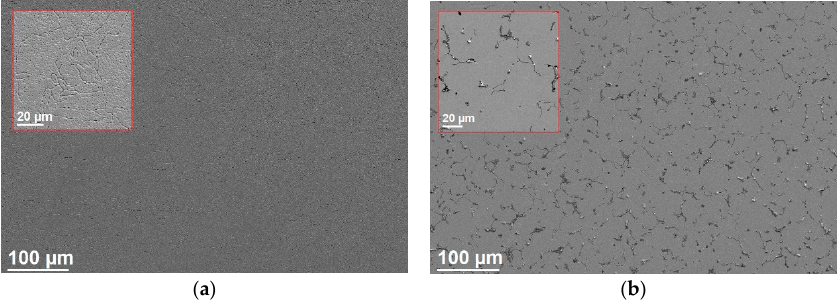
Figure 2. Scanning Electron Microscopy (SEM) images of the ( a ) Co-SLS and ( b ) Co-PIM samples.